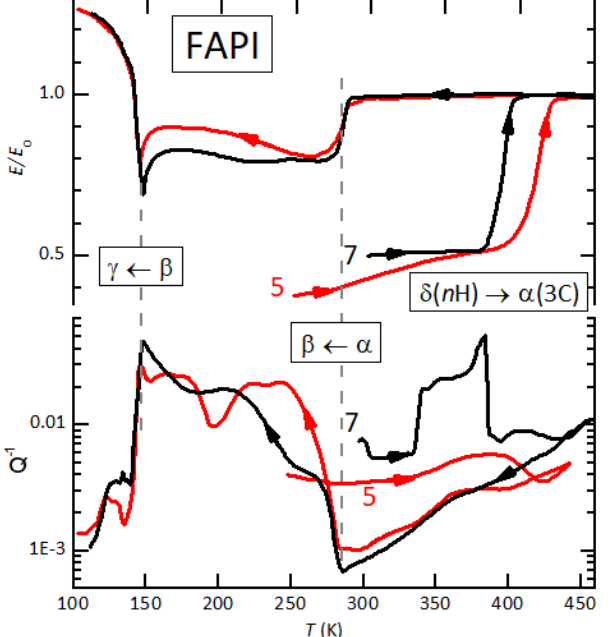
Figure 1. Relative change of the Young’s modulus and elastic energy loss vs T of FAPI #5 (dehydrated in high vacuum) and FAPI #7 (heating in 7 mbar H 2 O). Heating rate: ∼ 1.5 K/min. Adapted with permission from ref. [19]. Copyright (2020) American Chemical